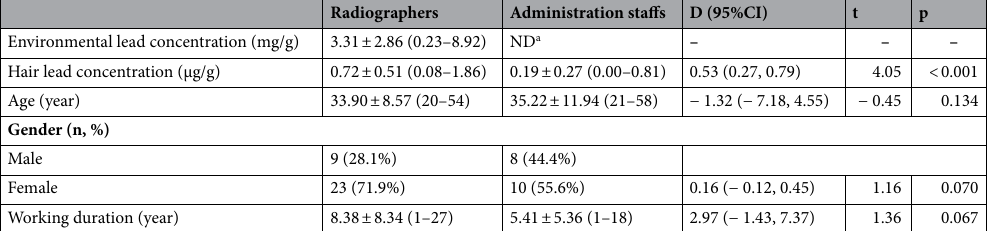
Table 1. Comparisons between the radiographers and administration staffs. a Not detected or below detection limit.